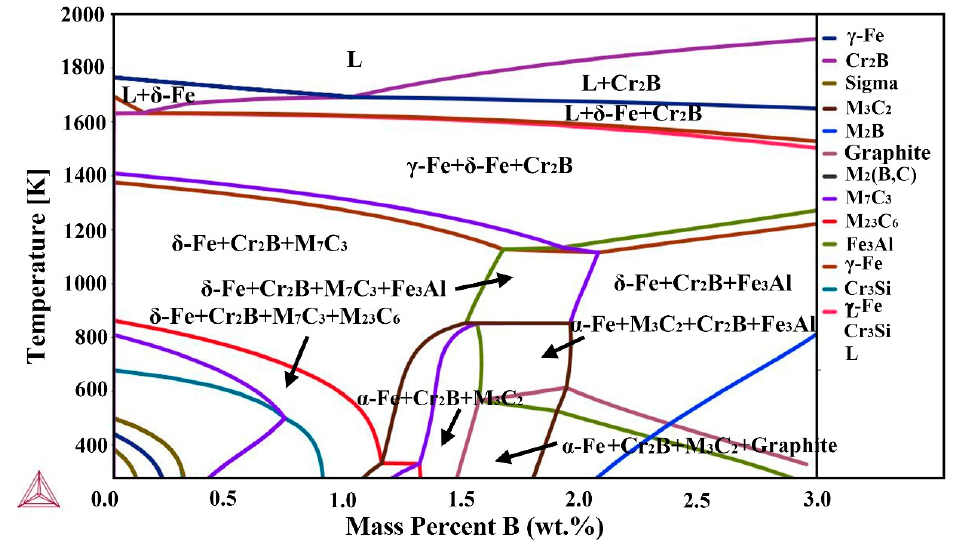
Figure 2. The calculated vertical sections of Fe-Cr-B-Al-C high aluminum and chromium Fe-B-C coatings.